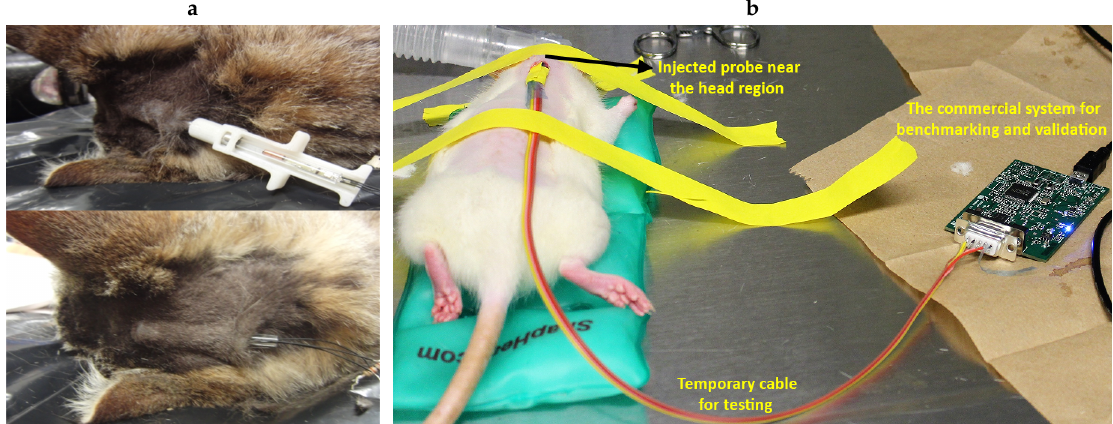
Figure 12. ( a ) Subcutaneous injection procedure demonstrated with a cat cadaver. (The picture has been republished from [13] with authors’ permission ©2014 IEEE.) ( b ) An anesthetized rat with the subcutaneously injected optical probe temporarily wire-connected to the commercial AFE4490 system for benchmarking and